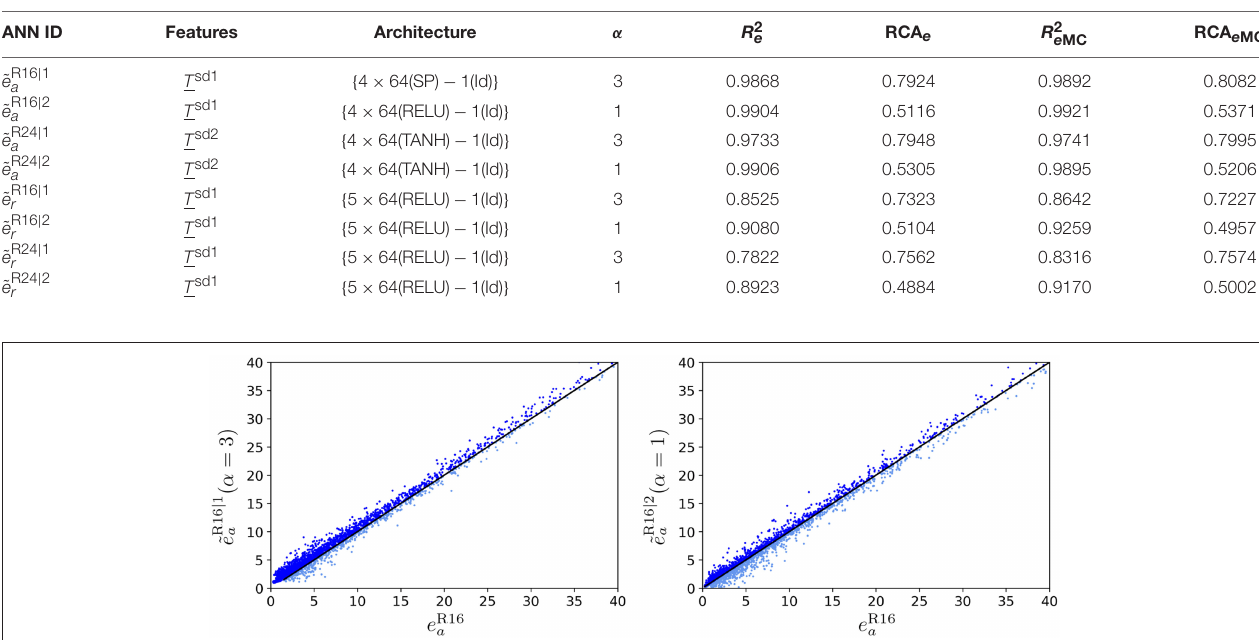
TABLE 3 | ANNs for error regression with corresponding choice of input feature, network architecture, penalty parameter α , corresponding quality indicators R 2 e and RCA e for the validation dataset and R 2 e MC and RCA e MC for the MC dataset.